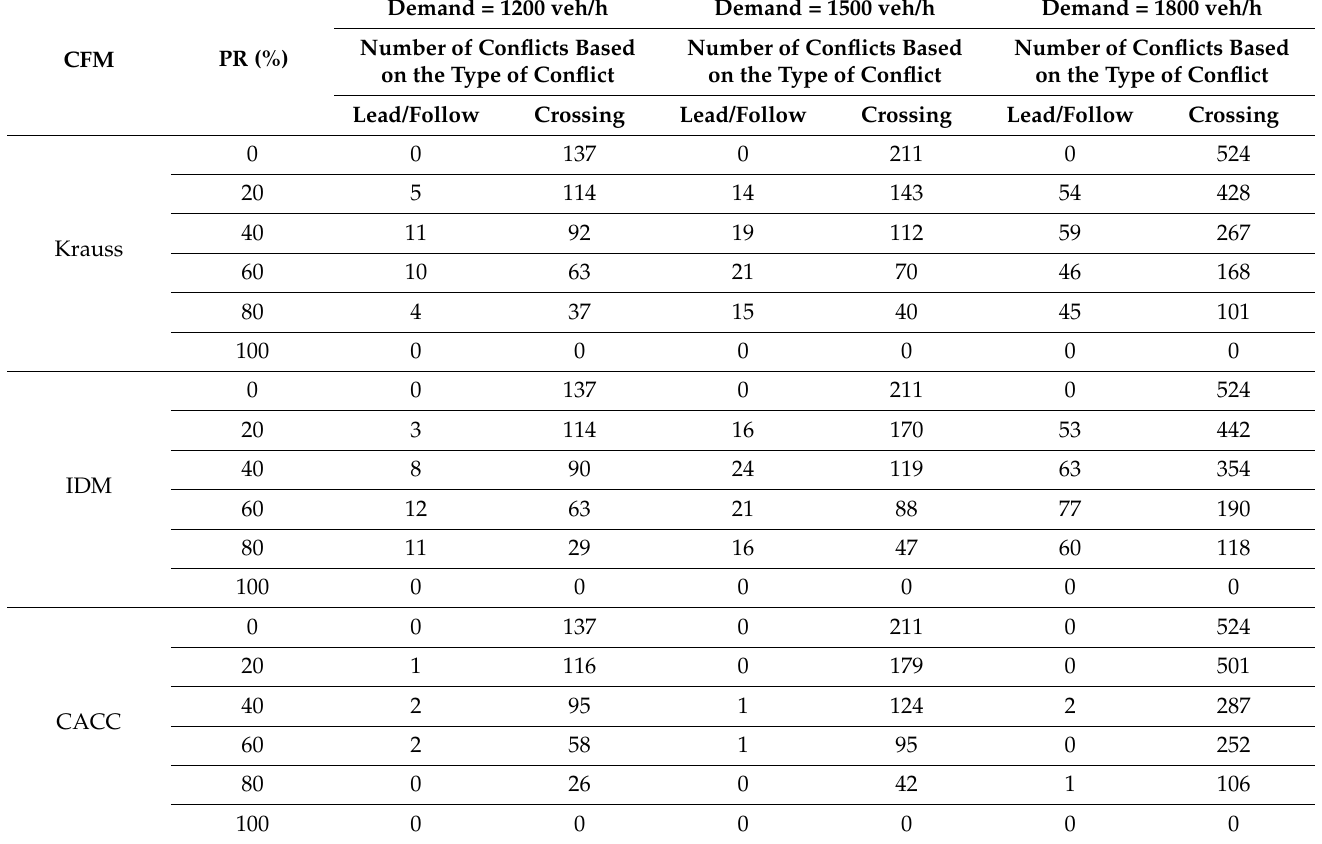
Table A2. Results of impact of CAVs on safety of unsignalized intersection network (CFM = car- following model, PR = penetration